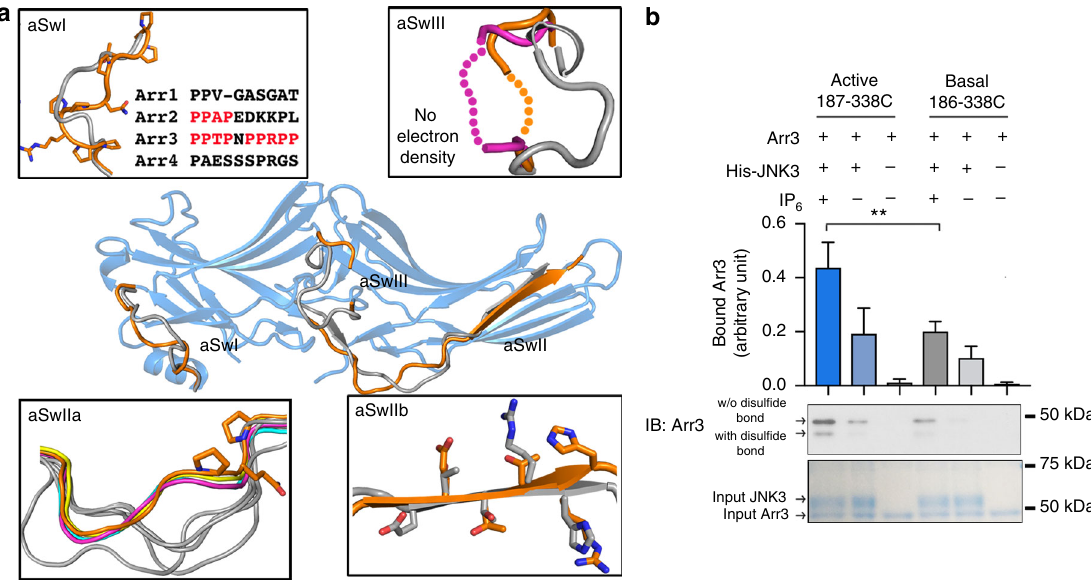
Fig. 5 Arrestin switch regions. a Conformations of the arrestin switch regions in the active form (orange (IP 6 -activated arrestin-3 (Arr3)), magenta (phosphopeptide-activated arrestin-2; PDB 4JQI 11 ), cyan (rhodopsin-activated arrestin-1; (PDB 4ZWJ 13 )), yellow (p44; PDB 4J2Q 10 )) differ from those in basal arrestin-3 (gray, PDB 3P2D 6 ). Insets highlight switch regions. In the inset showing aSwI, the sequences in four bovine arrestin isoforms are shown. b Quantitation of arrestin-3 binding to His 6 -JNK3 in the presence and absence of IP 6 (100 µ M), monitored using an in vitro pull-down assay. JNK3 was immobilized on Ni 2+ resin, exposed to arrestin-3 (with disul fi des stabilizing active or basal aSwIIb), washed, then eluted in sample buffer and visualized by SDS-PAGE and Western. Disul fi de trapped arrestin-3 (red box) was quanti fi ed separately by densitometry and the ratio was calculated (means ± SEM). ** p ≤ 0.01. The overall amount was normalized by the ratio of disul fi de trapped arrestin (Supplementary Fig.